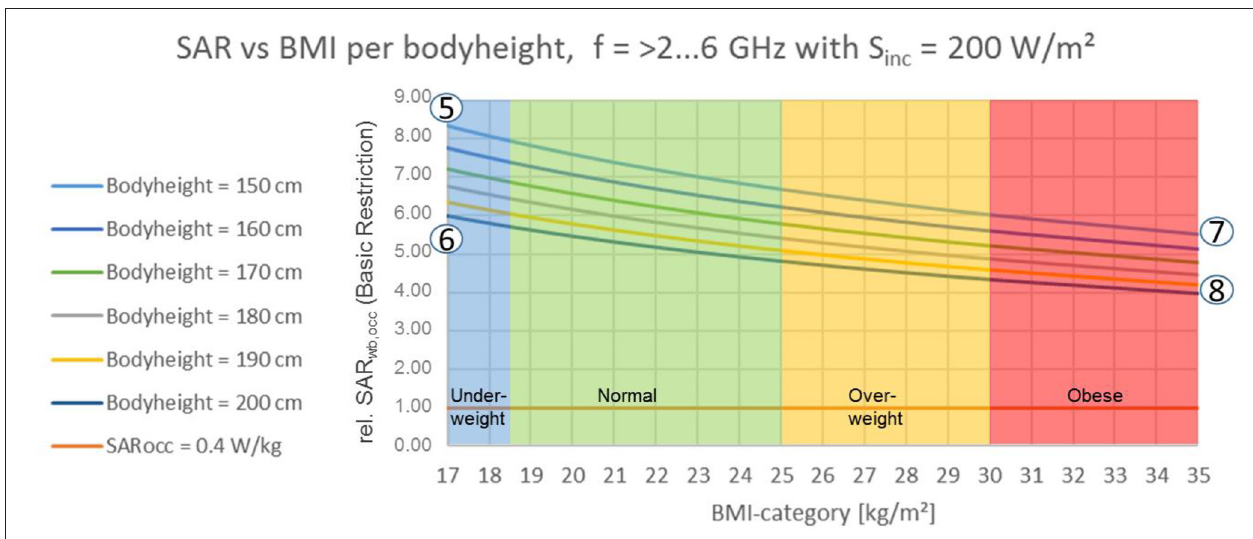
1/2): Effect of body height = 6min [according to ICNIRP 2020 (1) Table 6]. =